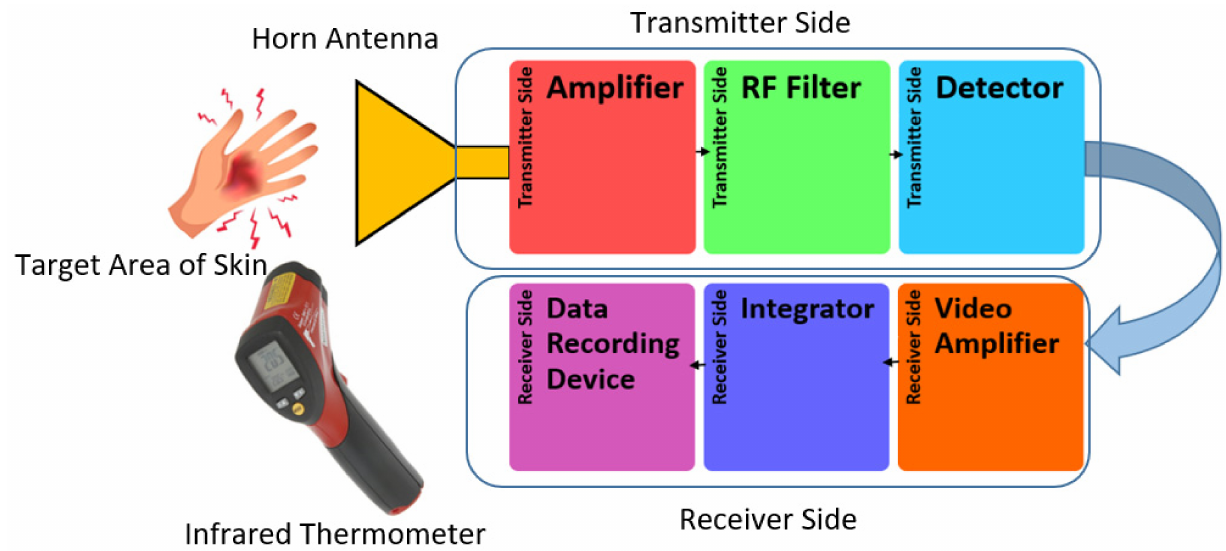
Figure 2. Experimental setup for the W-band radiometer used to measure the reflectance of healthy and unhealthy skin regions at a center frequency of 90